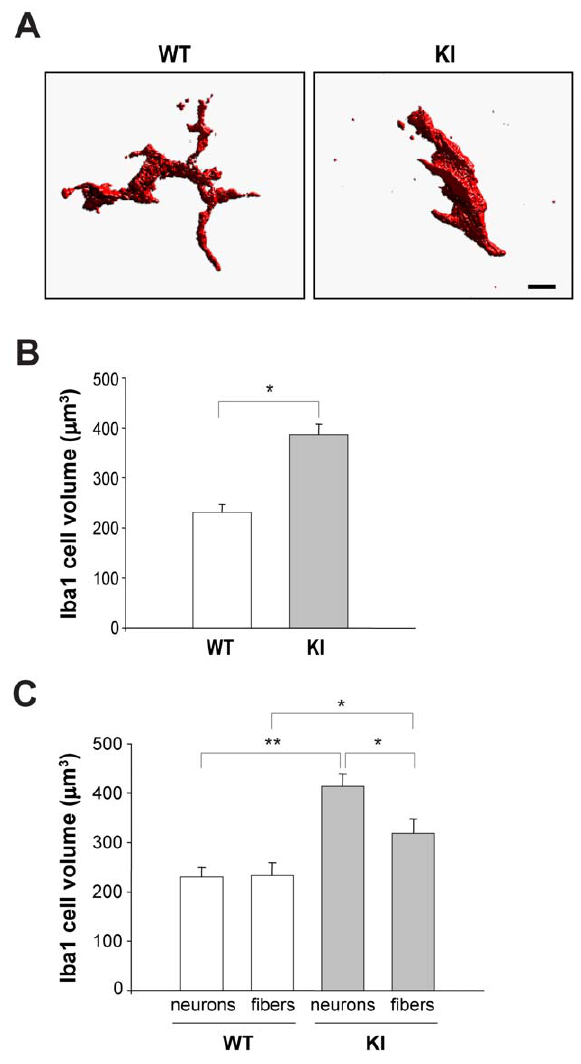
Figure 2. Different morphology of Iba1 immunoreactive cells in WT and R192Q KI trigeminal ganglia. A , Examples of 3D reconstruction of Iba1-positive cells (from confocal Z-stacks, each 0.5 m m-tick) from WT or R192Q KI ganglia. Note large branching of WT cell vs compact, process-free KI cell morphology. Scale bar: 5 m m. B , Histograms quantify average volume ( m m 3 ) of Iba1-positive cells in WT and R192Q KI ganglia, obtained from voxel analysis of 3D images. Data were collected from three independent experiments with a total of 83 cells for WT and 70 cells for R192Q KI; * p , 0.001. C , Histograms quantify the average volume of Iba1-positive cells from different neurons or fibers enriched areas of WT and R192Q KI ganglia; n =20–50 cells (3 WT and 3 KI mice). * p , 0.05; ** p ,